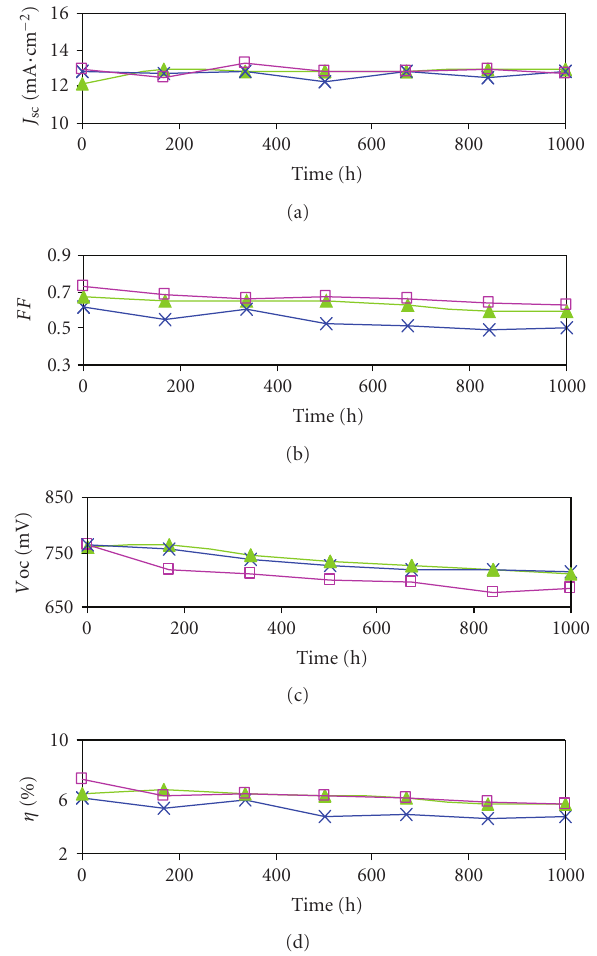
Figure 3: Evolution of photovoltaic parameters for device A ( (cid:2) ), device B ( × ), and device C ( (cid:3) ). The cells were kept under one sun visible-light soaking at 5 ◦ C for approximately 1000